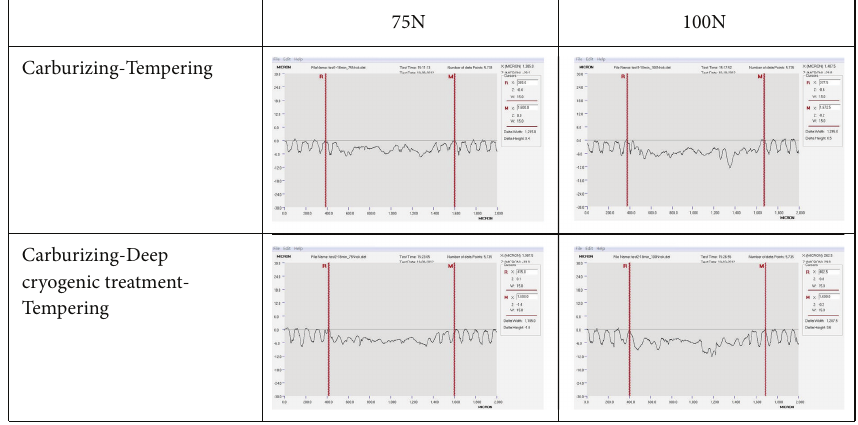
Figure 7: The wear profile for the SCM415